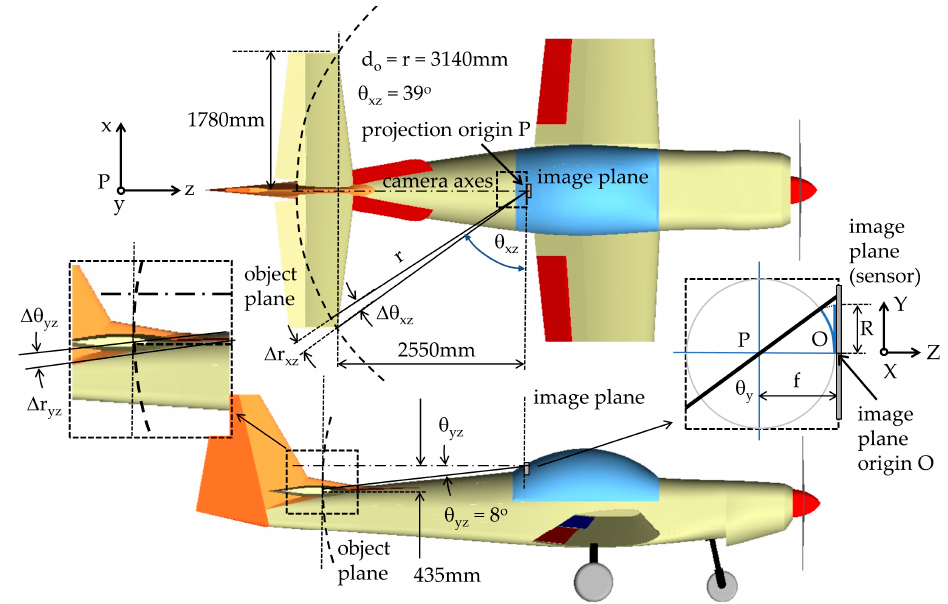
Figure 6. Imaging geometry showing the object and image plane variables.